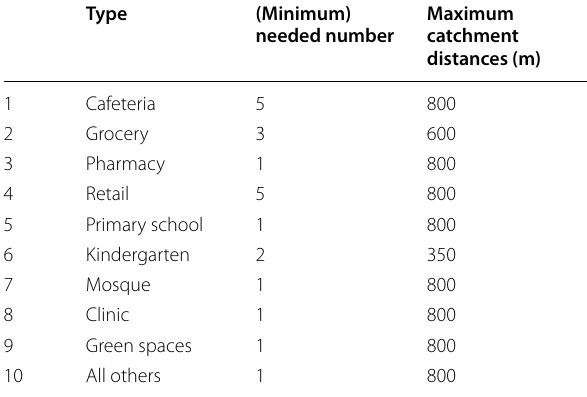
Table 1 Customized types and numbers of amenities, and their catchment distances for Emirati neighborhoods